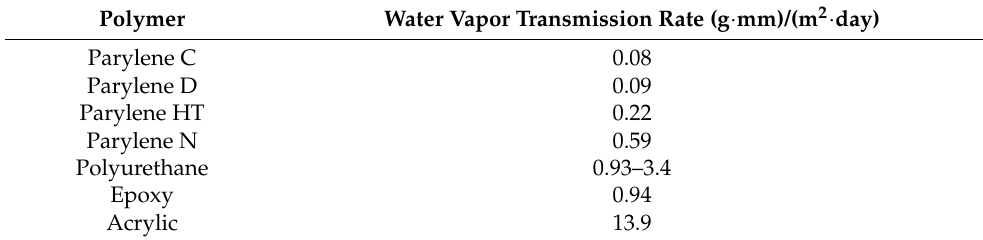
Table 1. Comparison of waterproof properties with polymer materials